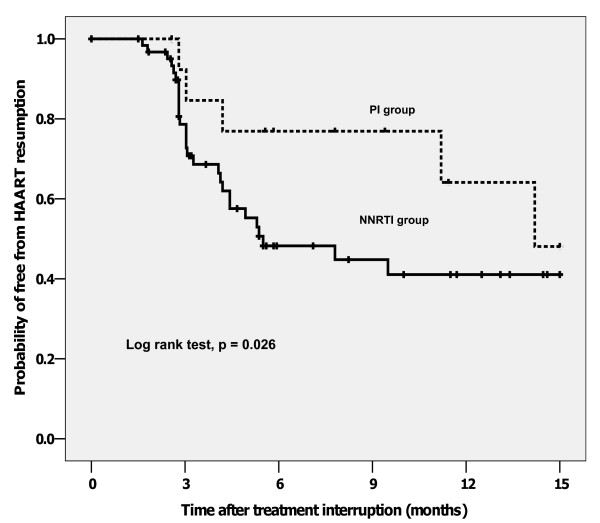
Kaplan-Meier analysis for the probability of free from ART resumption.